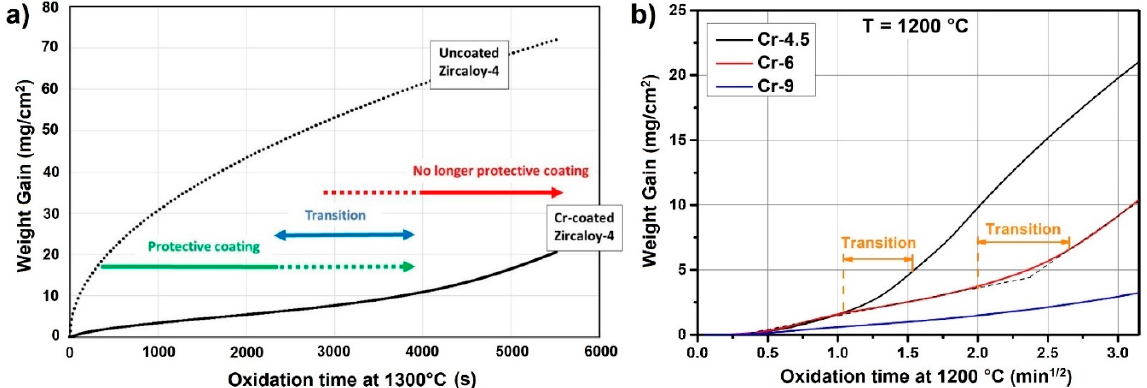
Figure 12. Mass gain evolution measured by TGA: ( a ) 10–15 µm Cr-coated Zry-4 alloy in helium–oxygen mixture at 1300 °C (reproduced from [166] with permission by Elsevier); ( b ) 4.5–9 µm Cr-coated E110 alloy in steam at 1200 °C (reproduced from [165] with permission by Elsevier).